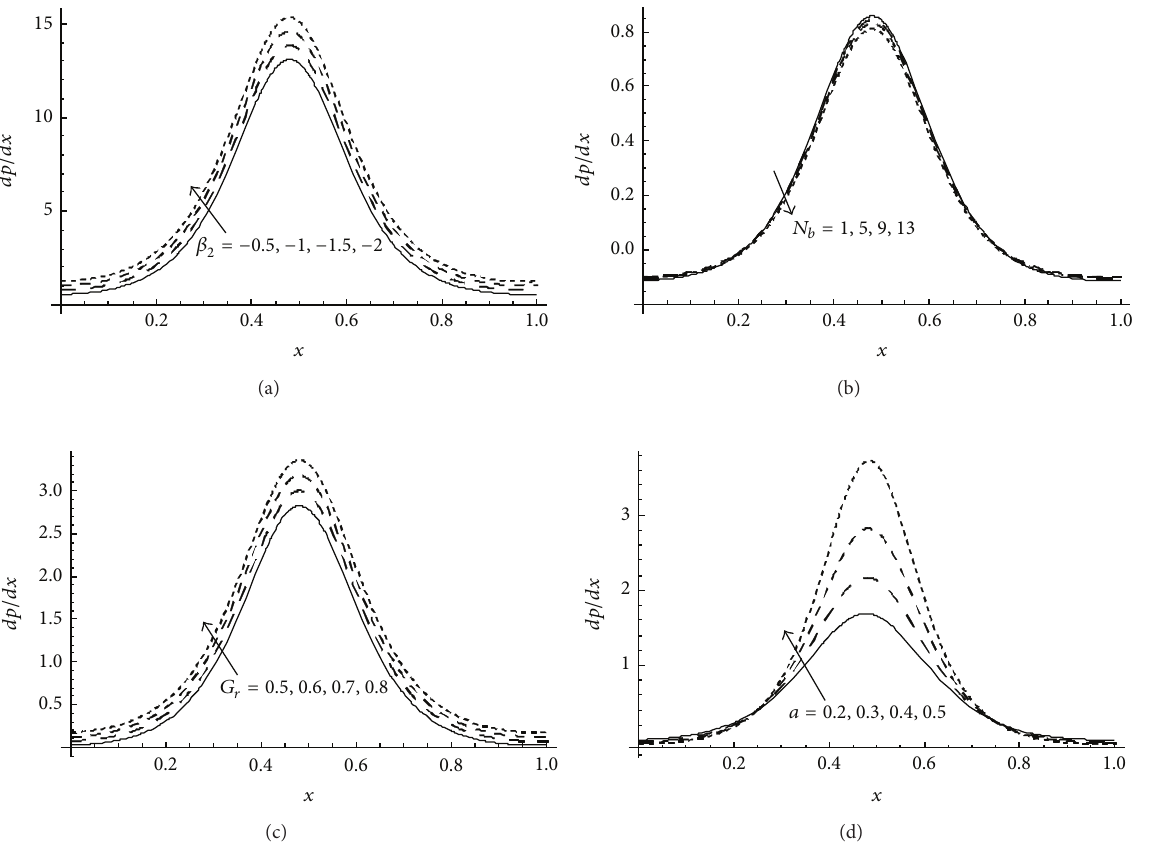
Figure 12: Variation of the pressure gradient at 𝑏 = 0.5 , 𝑑 = 1 , 𝑁 𝑡 = 0.5 , 𝐵 𝑟 = 0.5 , 𝜙 = 0.2 , 𝑄 = 0.5 , and 𝛾 = 𝛾 1 = 0.5 for (a) 𝛽 1 = 0.1 , = 0.8 , 𝐺 = 0.5 , 𝑎 = 0.3 , and 𝛽 = −0.5, −1, −1.5,−2 ; (b) 𝛽 𝑁 𝑏 𝑟 2 = 0.8 , 𝑎 = 0.3 , and 𝐺 = 0.5, 0.6, 0.7, 0.8 ; and (d) 𝛽 𝑁 𝑏 𝑟